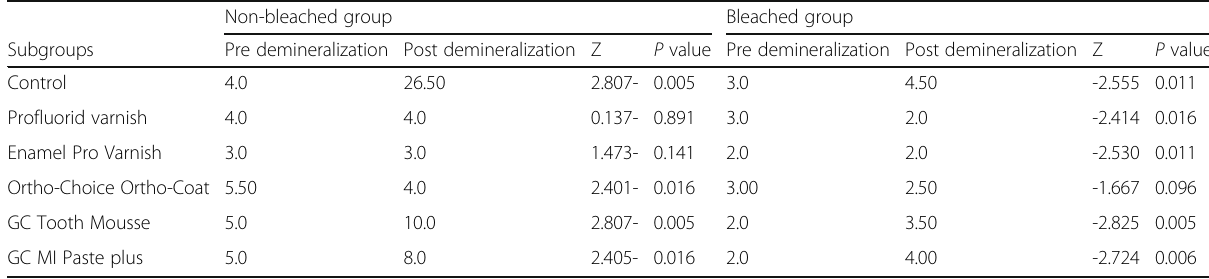
Table 3 Medians of pre and post demineralization DIAGNOdent values for bleached and non-bleached